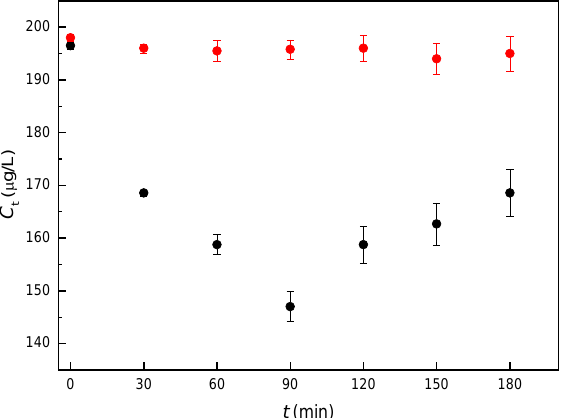
Figure 2. Concentration ( C t ) of free, sperm-unbound α E2 measured at the individual capacitation time using the optimized HPLC-MS/MS method. Each experiment was carried out for biological samples with added rat sperm (black circles) and for reference samples without sperm (blanks, red circles). Samples were prepared in three parallel sets representing sperm collected from one male. Three animals were used, and error bars were calculated using standard deviation ( n = 3), for details see Section 4.3. Sample preparation and evaluation. Table 1. The relative concentration B t , obtained for the individual capacitation times, mean ± standard error of the mean ( n =